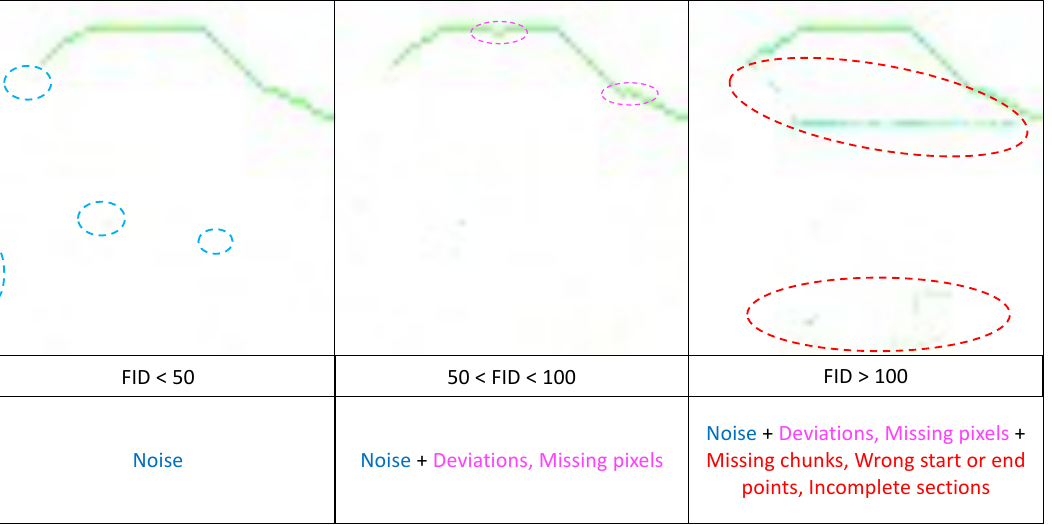
Figure 3. Heuristic representation of what errors are generated depending on the FID